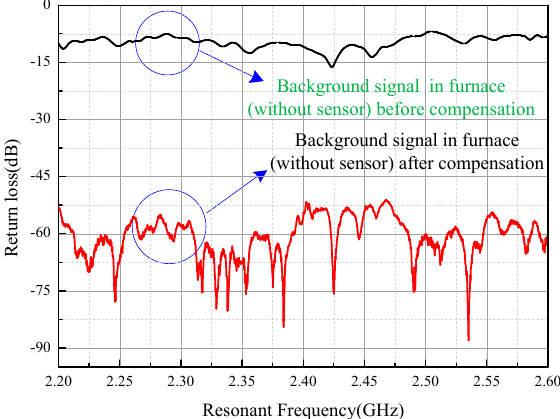
Figure 9. Power of the background clutter before and after frequency-domain compensation in the metal-sealed chamber.